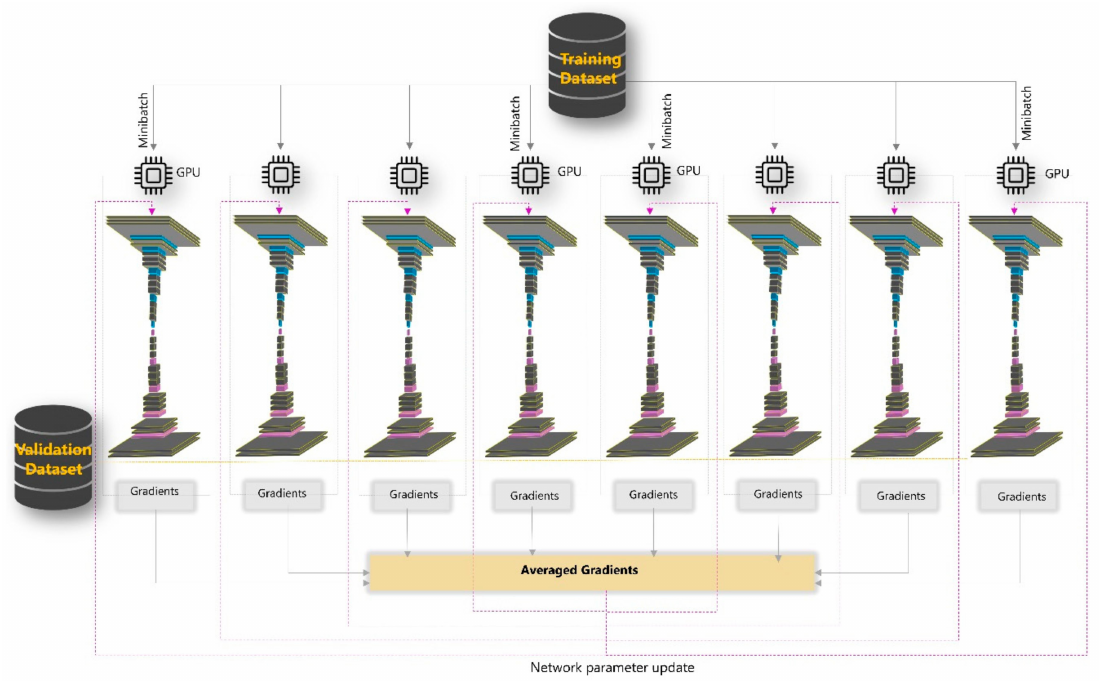
Figure 6. Mirrored distributed training